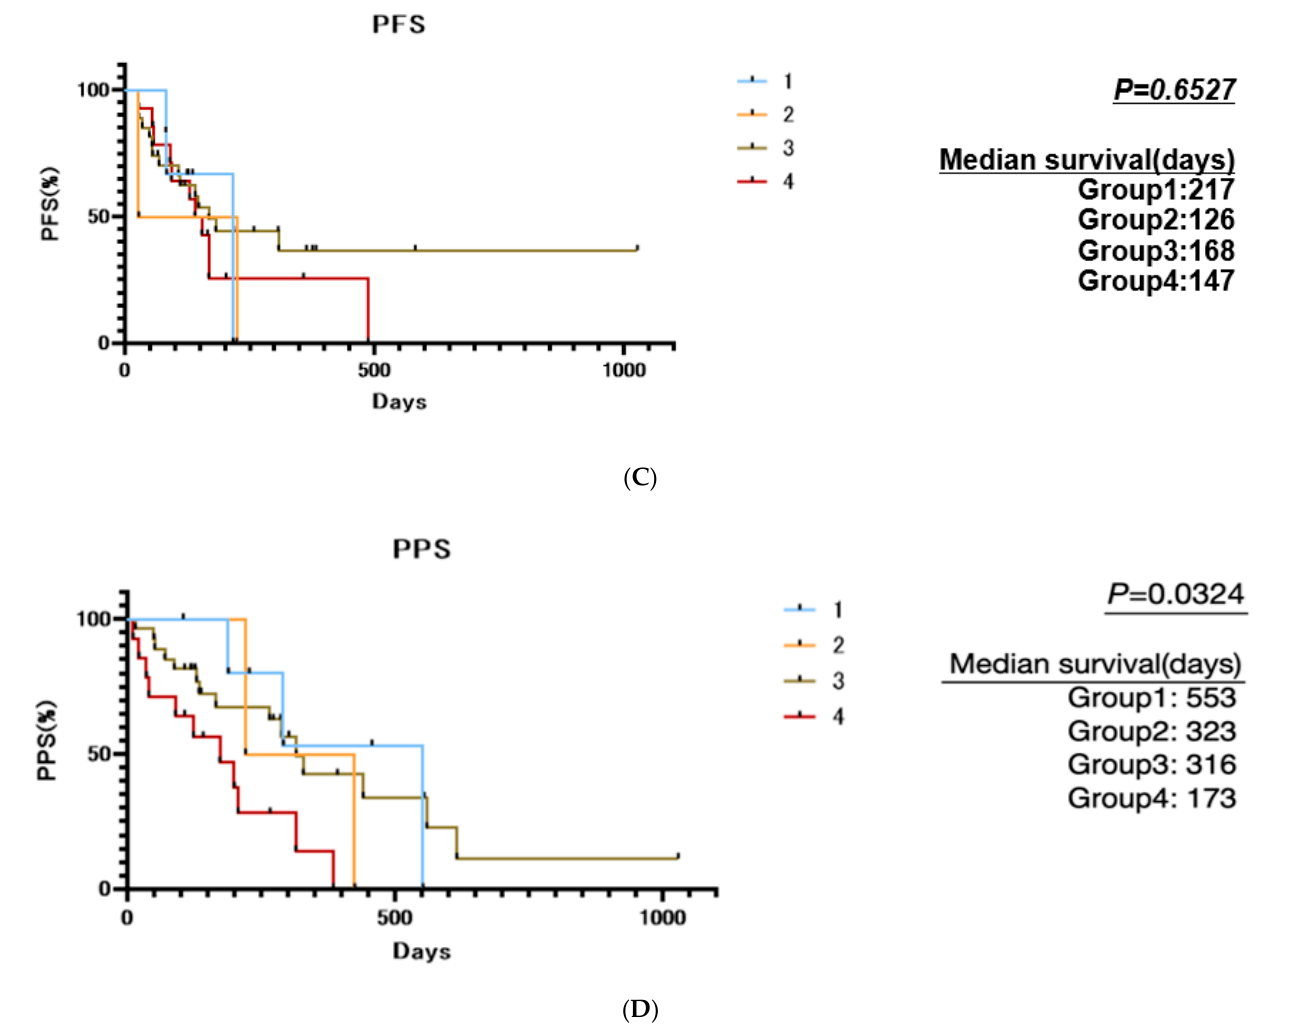
Figure 4. Cluster analysis based on the rate of changes in ANG-2, HGF, and EGF between best response and progressive disease points: ( A ) The rate of changes in EGF, ANG-2, and HGF between best response and progressive disease points in patients with SD, PR, and CR were visualized using a heat map and clustered by average linkage clustering methods using Heatmapper [23]. ( B ) Changes in ANG-2, HGF, and EGF between best response and progressive disease points in the four classified groups. Group 1 had a remarkable increase in EGF, group 2 had a remarkable increase in ANG-2, group 3 had no increase in growth factors but had a decrease in EGF, and group 4 had an increase in all three growth factors (ANG-2, HGF, and EGF). ( C ) Comparison of progression-free survival among the four classified groups based on rate of changes in ANG-2, HGF, and EGF between best response and progressive disease points. ( D ) Comparison of post progression survival among the four classified groups based on rate of changes in ANG-2, HGF, and EGF between best response and progressive disease points. Asterisks indicate statistically significant differences (* p < 0.05, ** p < 0.01, **** p < 0.0001, ns: not significant).